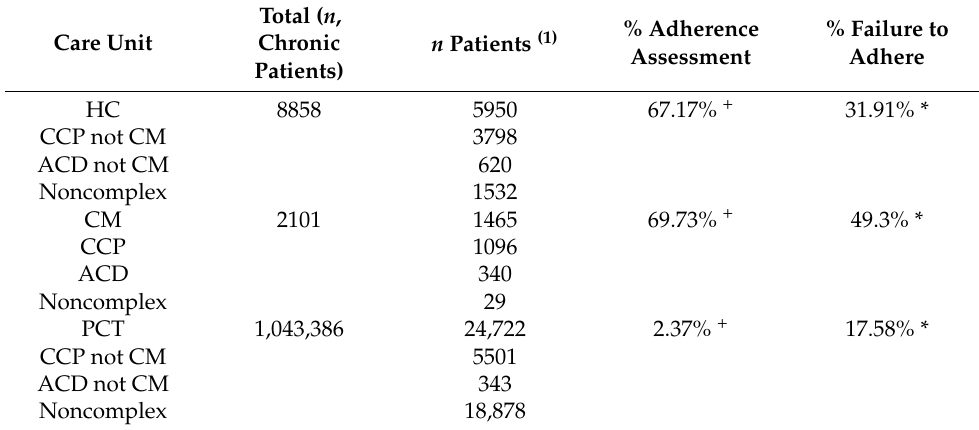
Table 3. Distribution of adherence records and percentage of failure to adhere based on care unit. Total ( n , % Adherence % Failure to Care Unit Chronic n Patients (1) Assessment Patients)